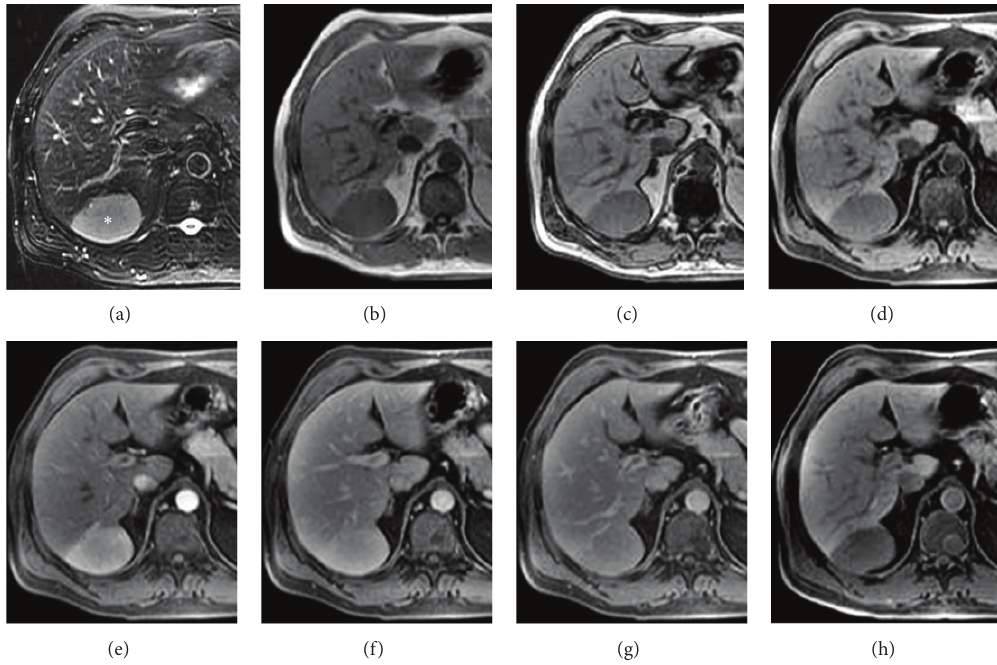
Figure 12: Primary hepatic NH lymphoma. (a) On T2w image well-defined homogeneous moderate hyperintense nodule (asterisk) in S VII. (b-c) T1w in- and out-phased images. The lesion appears homogeneously moderate hypointense on T1w sequences. (d–g) On contrast enhanced MRI the mass shows homogeneous hypervascular enhancement in arterial phase (e) and becomes isointense to liver parenchyma on portal and late dynamic phases. (h) In epatobiliary phase the nodule is homogeneously